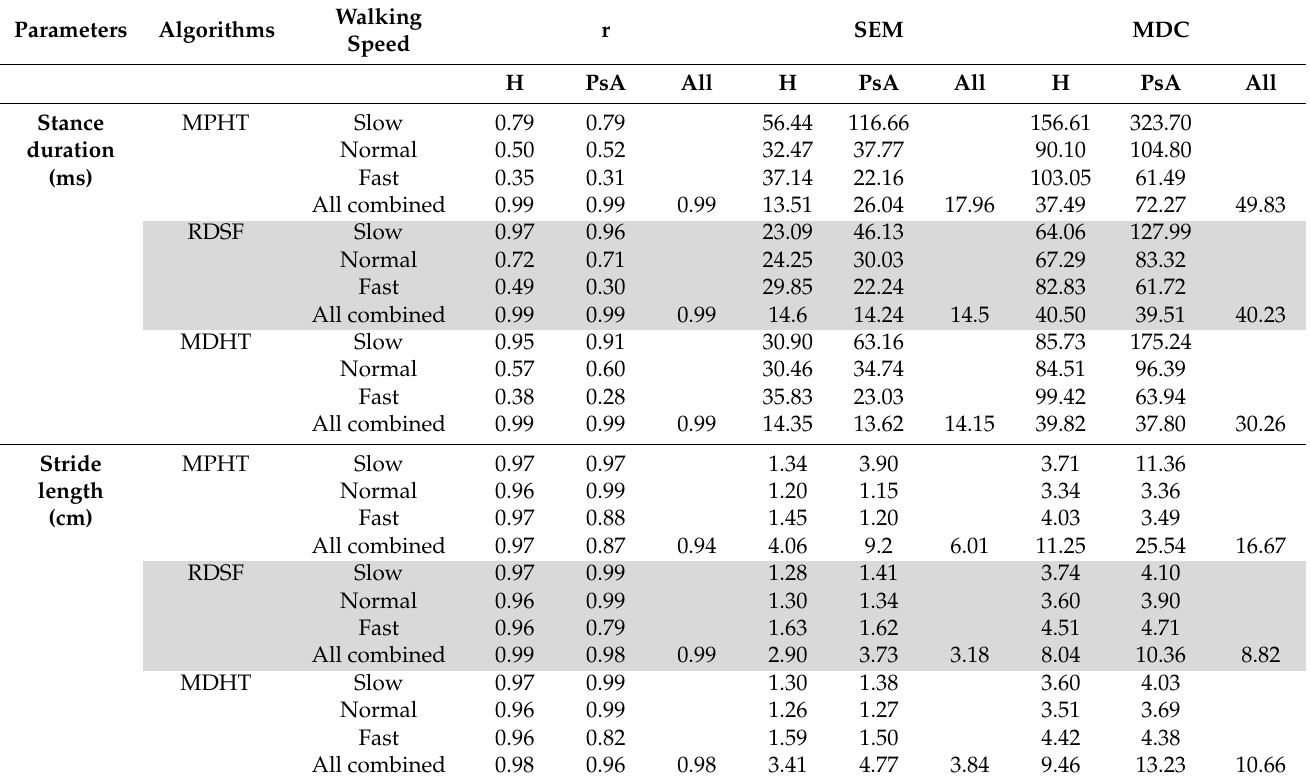
Figure 4. Bland–Altman plots of clinical parameters. ( A ) Bland–Altman plots of the stance phase (s) calculated from each MoCap-based algorithm. ( B ) Bland–Altman plots of the stride length (m) calculated from each MoCap-based algorithm. Each plot contains data points of all gait events for the three walking speeds. The straight line represents the mean error, and dashed lines represent the limit of agreement within the 95% confidence interval. Table 3. Reliability coefficient (r), SEM, and MDC of the clinical Table 2. Clinical gait assessment parameters values and accuracy compared to force plates for slow, normal, and fast walking speed.